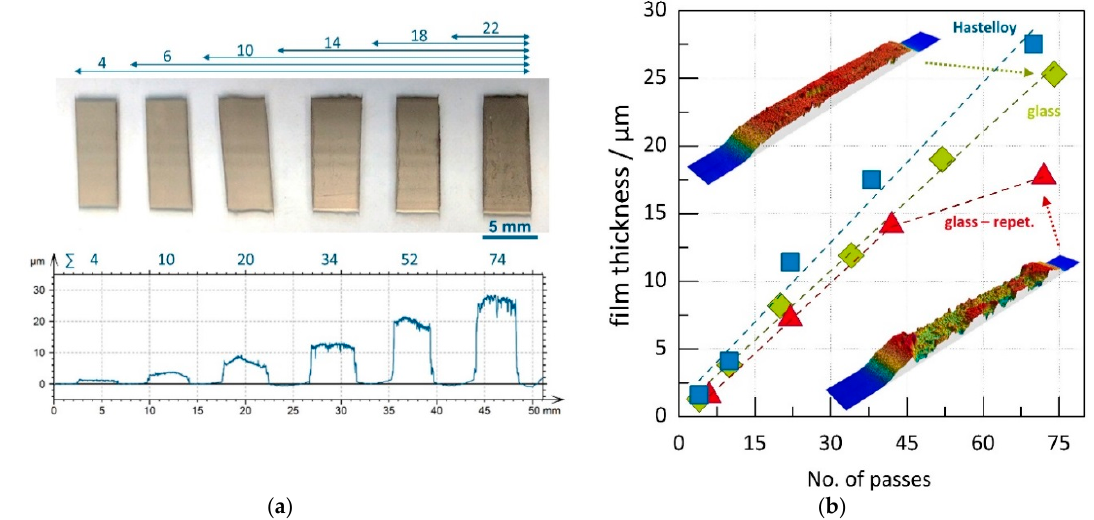
Figure 6. Variation of substrate passes: ( a ) image of films on glass substrate and corresponding profile and ( b ) film thickness vs number of passes for different substrates. Dotted lines serve as guide for the eye.